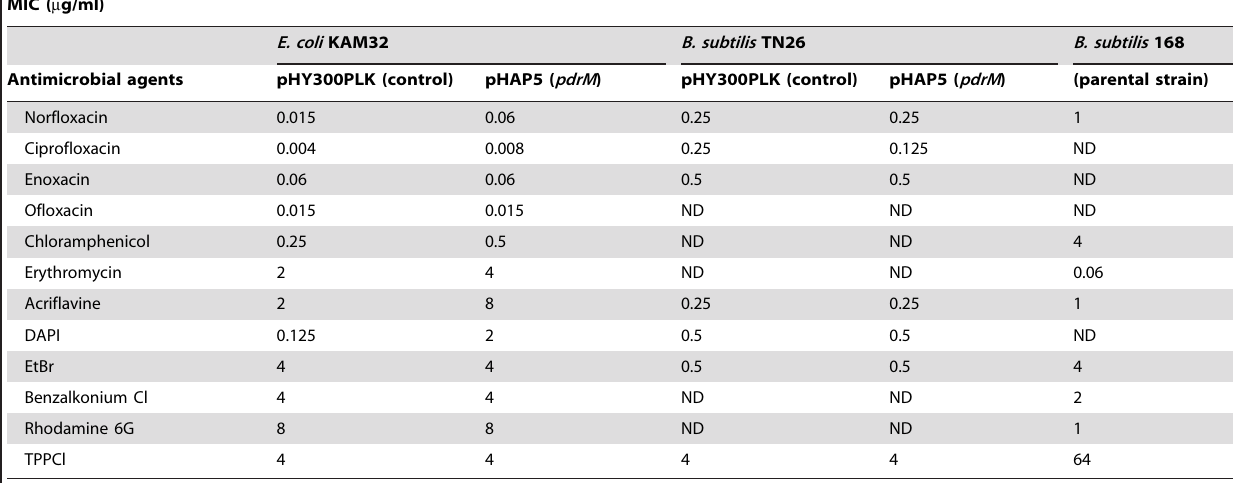
Table 2. Drug susceptibility in cells transformed with pdrM.